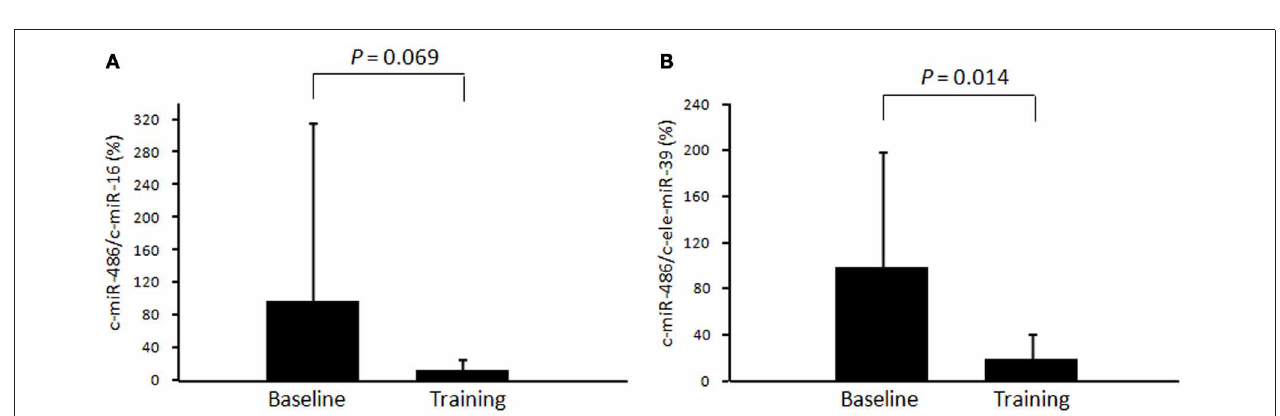
for miR-16 (A) and cel-miR-39 (B) was calculated for each serum sample. Values represent the mean ± standard deviation obtained from 11 subjects.